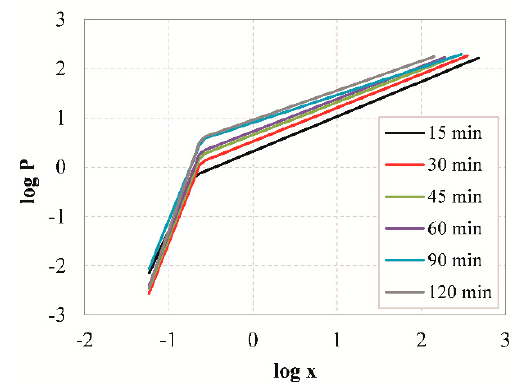
Figure 9. Log-log plots of particle size distributions of slag particles obtained after grinding for different times, using piecewise regression analysis.